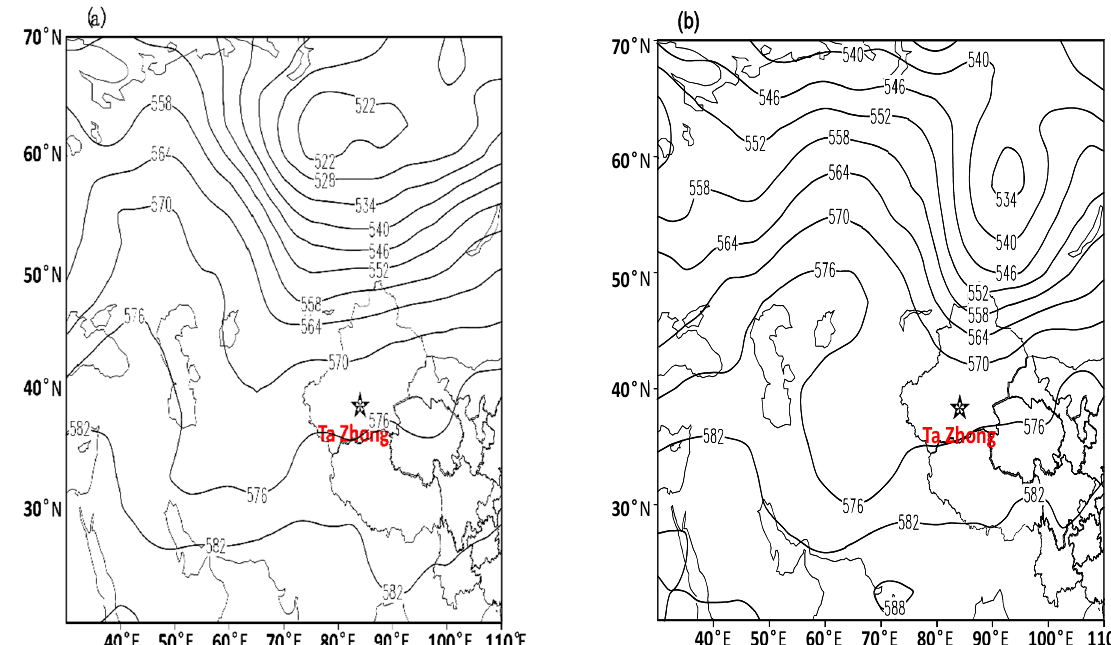
Figure 5. The 500 hPa geopotentialheight fields (10 m) ( a ) at 08:00 on 18 May and ( b ) at 08:00 on 20 Figure 5. The 500hPa geopotentialheight fields(10m)( a ) at 08:00 on 18 May and ( b ) at 08:00 on 20May.